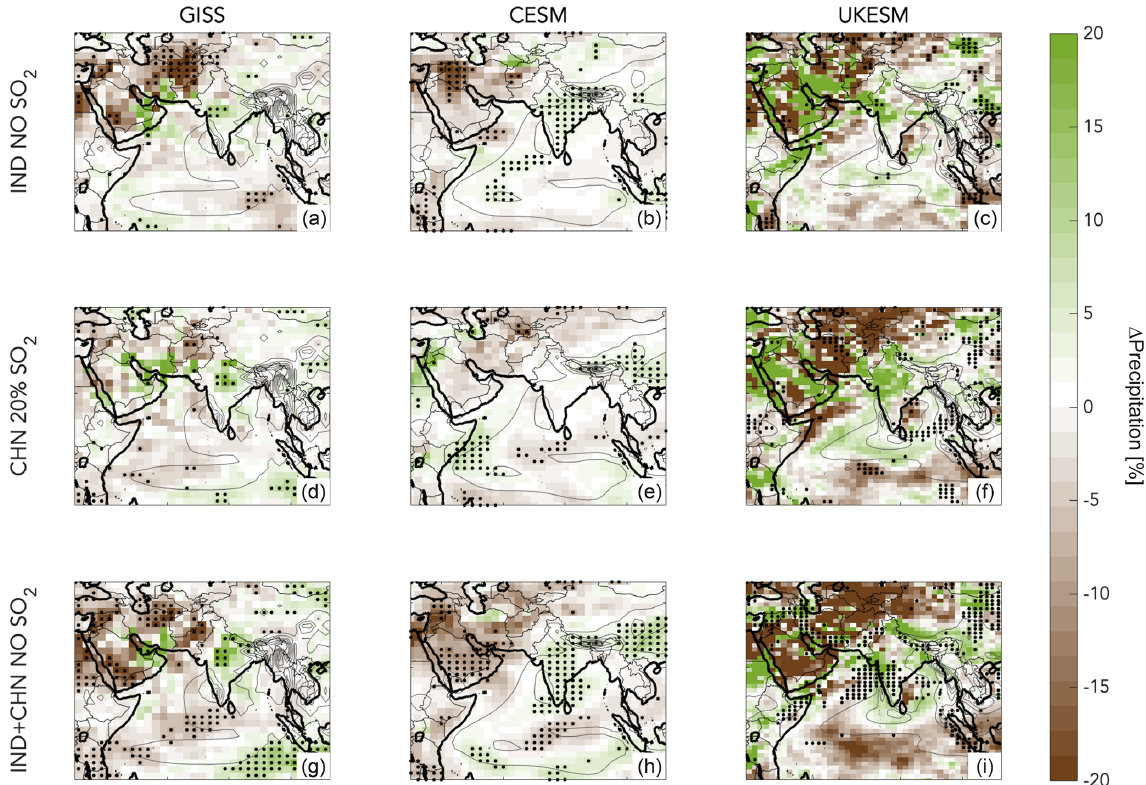
Figure 4. JJAS precipitation percentage difference between the SO 2 regional emissions scenarios and the CTRL runs. The columns represent the different models, and rows represent the different emissions scenarios. Stippled regions denote areas where the difference is significant at a 90% confidence level for a two-sample t test. Grey contours indicate mean JJAS precipitation from the control experiment for each model at 5mmd − 1 intervals.